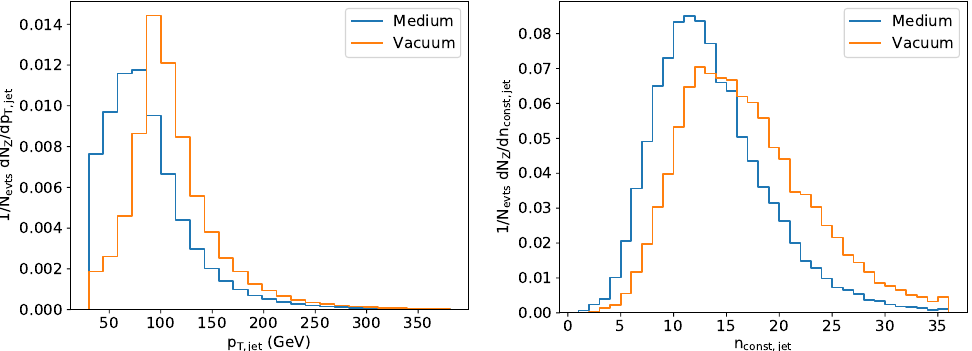
Figure 2 . Distribution of the (left) jet transverse momentum p T, jet and (right) number of jet constituents n for the JEWEL+PYTHIA Vacuum and Medium const